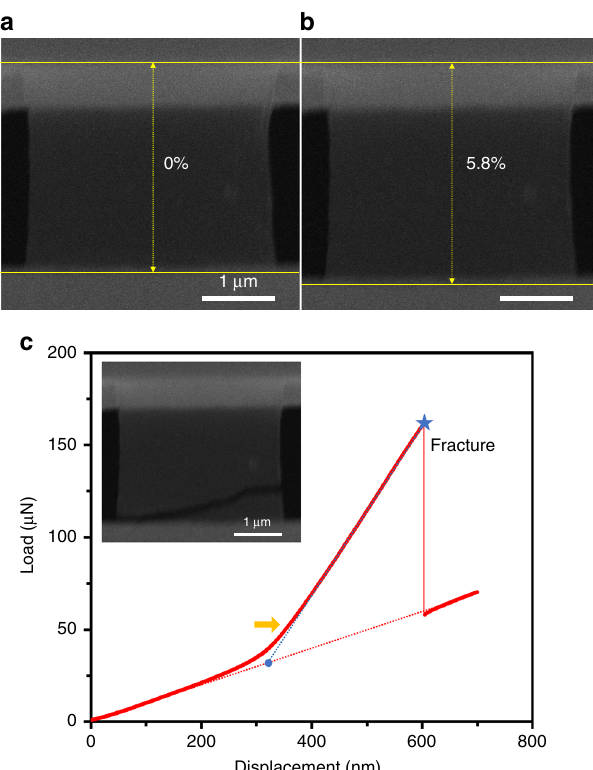
Fig. 3 Tensile fracture of the free-standing graphene. a SEM image shows that the tested graphene sample under fully tightened state, with the scale bar shows 1 μ m. b SEM image right before the tensile fracture, showing the peak strain state. c The corresponding indenter load-displacement curve, in which the blue dotted curve shows the linear fi tting after the graphene sample being fully tightened and stretched (indicated with the orange arrow) while the inset shows the brittle fracture of the sample upon